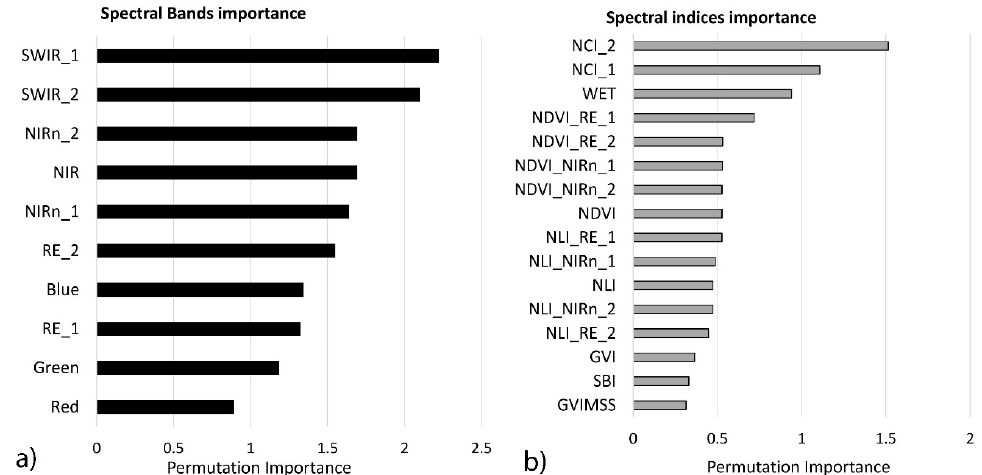
Figure 3. The most important predictor variables in rank order, using the permutation importance of ( a ) spectral bands and ( b ) spectral indices datasets. ( a ) spectral bands and ( b ) spectral indices datasets.